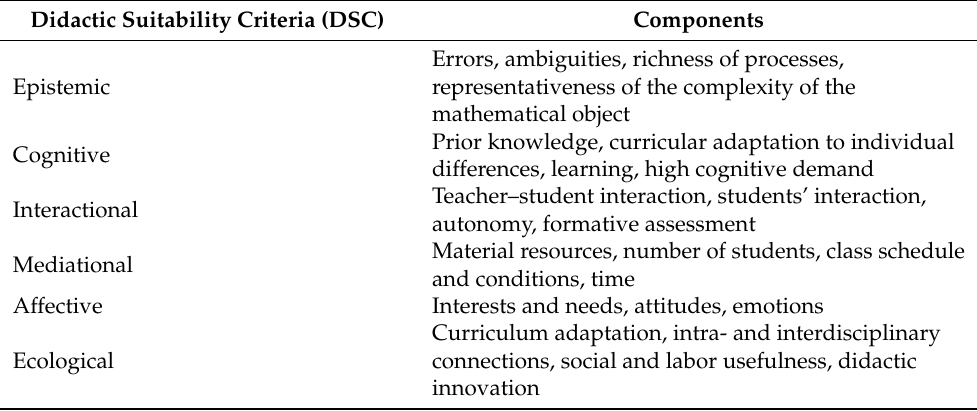
Table 1. Didactic suitability criteria and